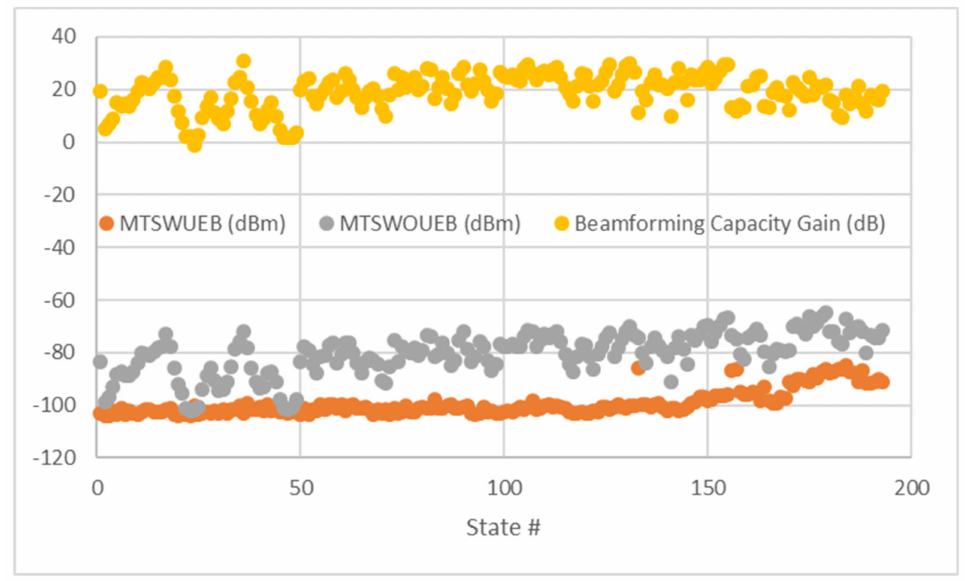
Figure 3. 5G beamforming capacity gain measured using an EMITE F200 reverberation chamber.